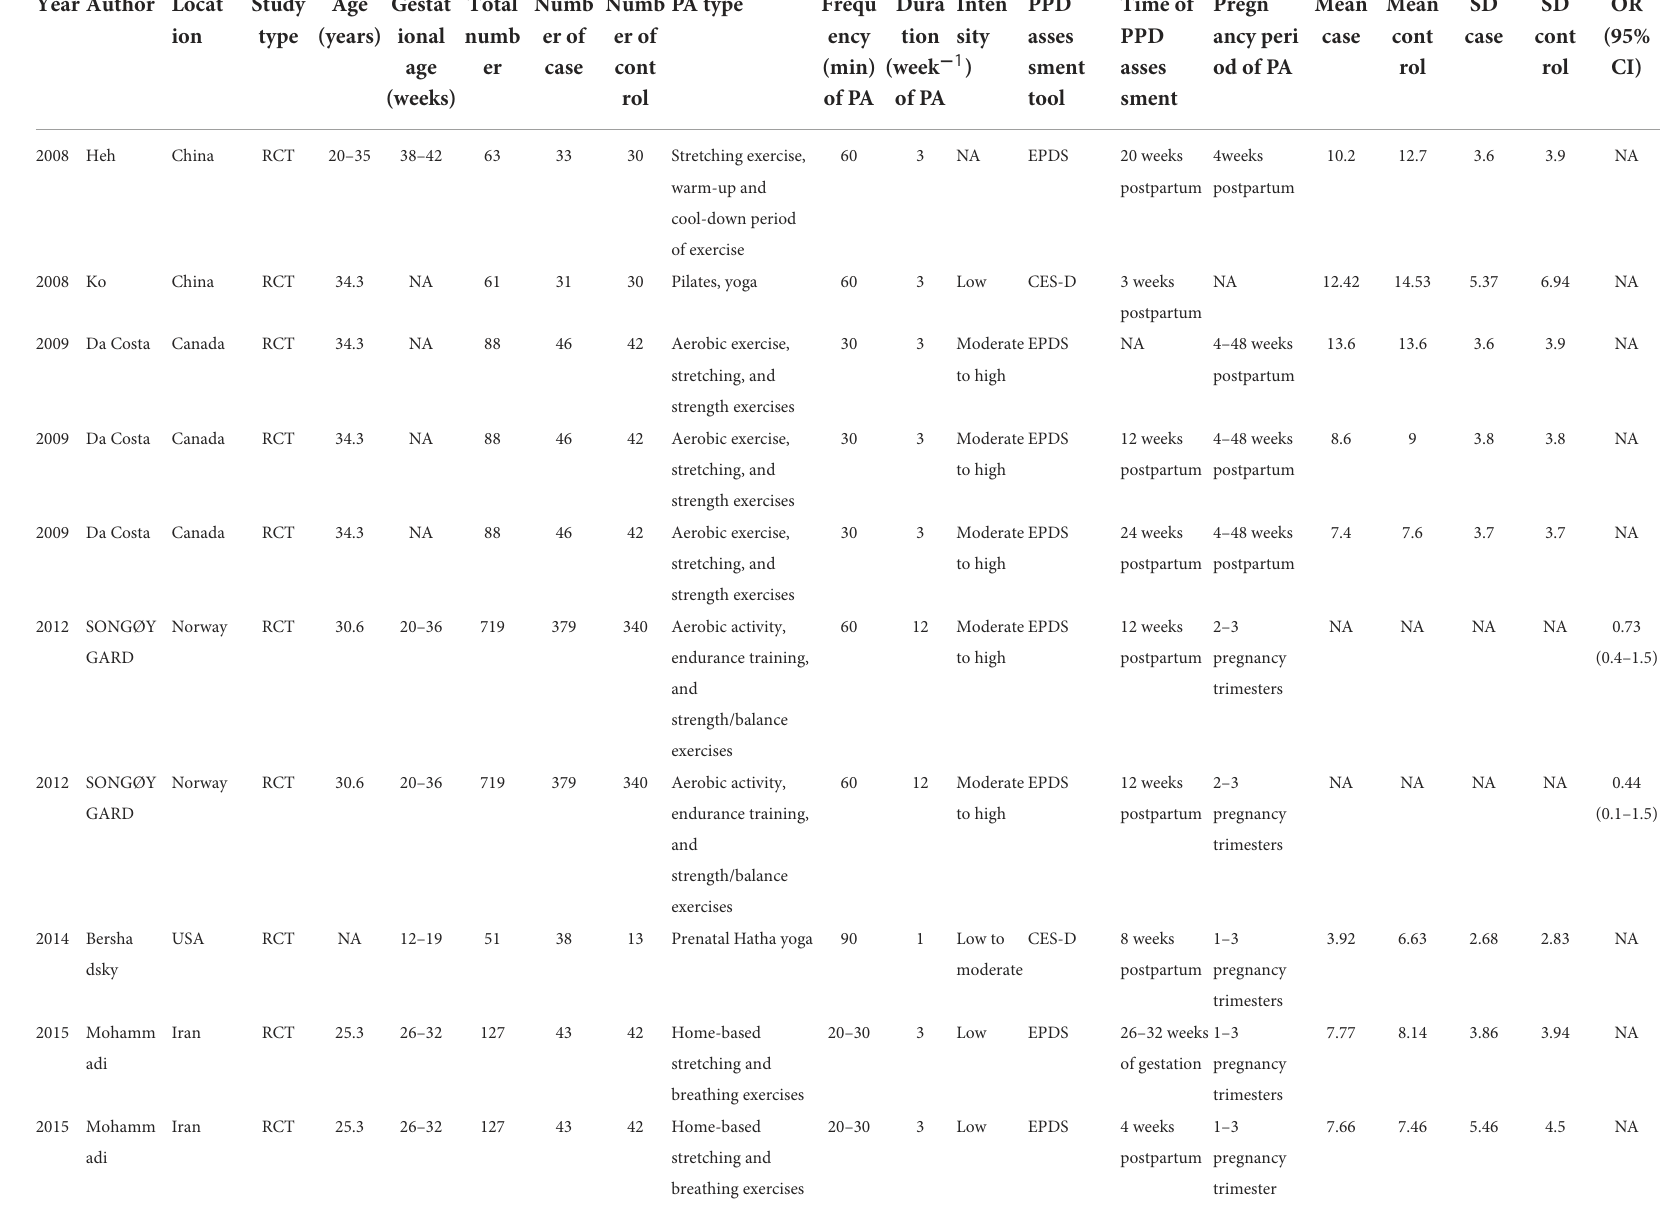
TABLE 1 Baseline characteristics of the studies included in this